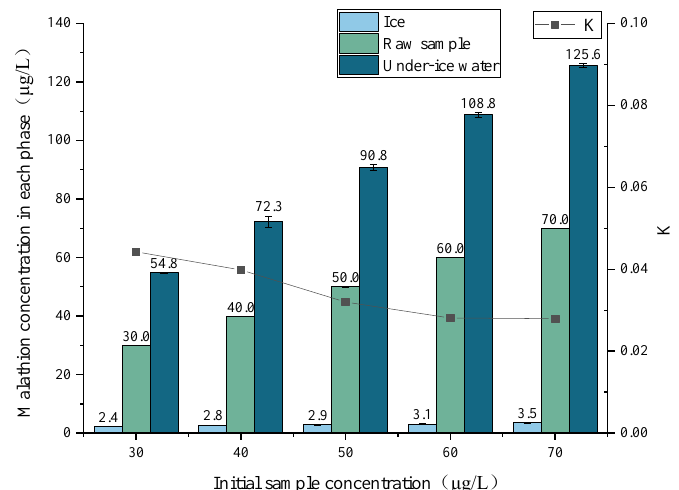
Figure 3. Migration rule for the different initial sample concentrations of malathion.